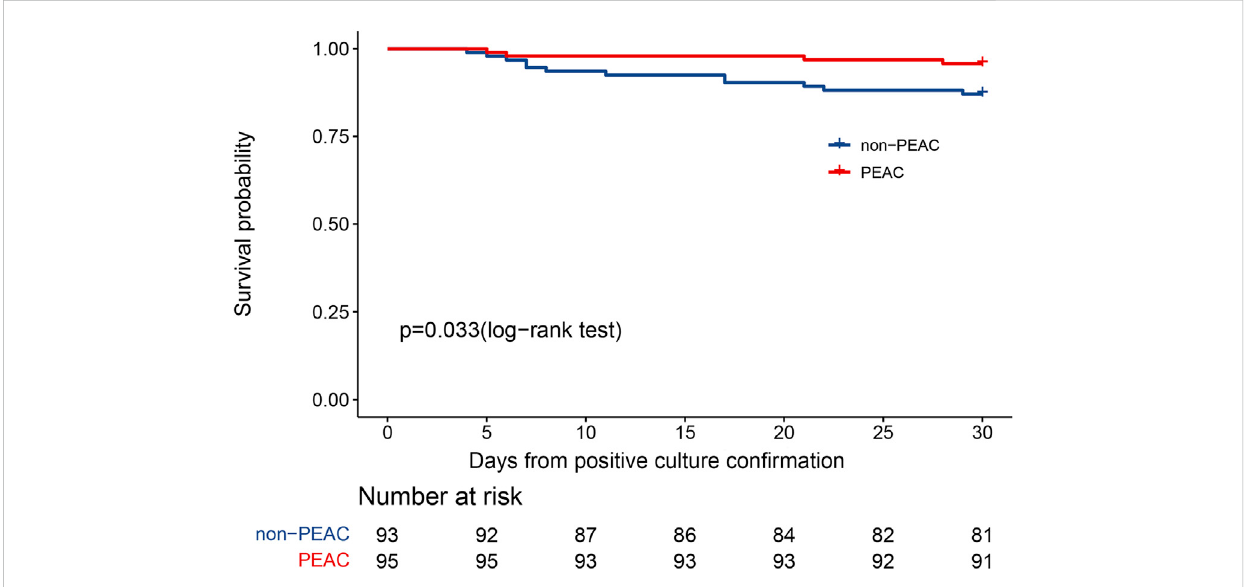
FIGURE 1 Kaplan – Meier curve illustrating the effect of pharmacist early active consultation (PEAC) vs. non-PEAC on 30-day all-cause mortality after positive MDRO